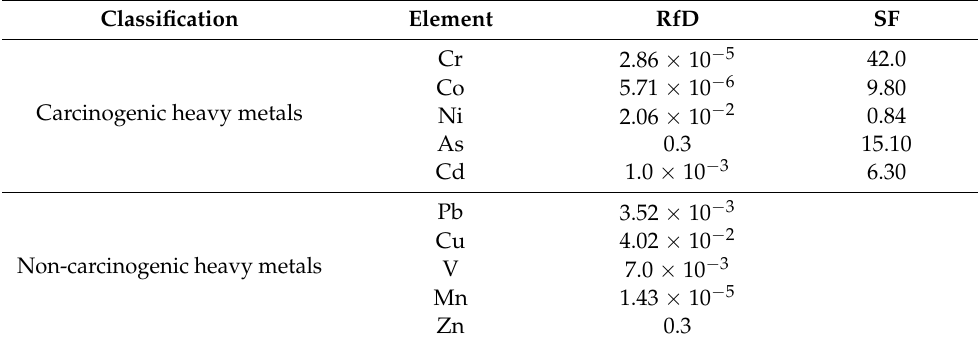
Table 3. Dose-response parameters for heavy metal elements entering the body through